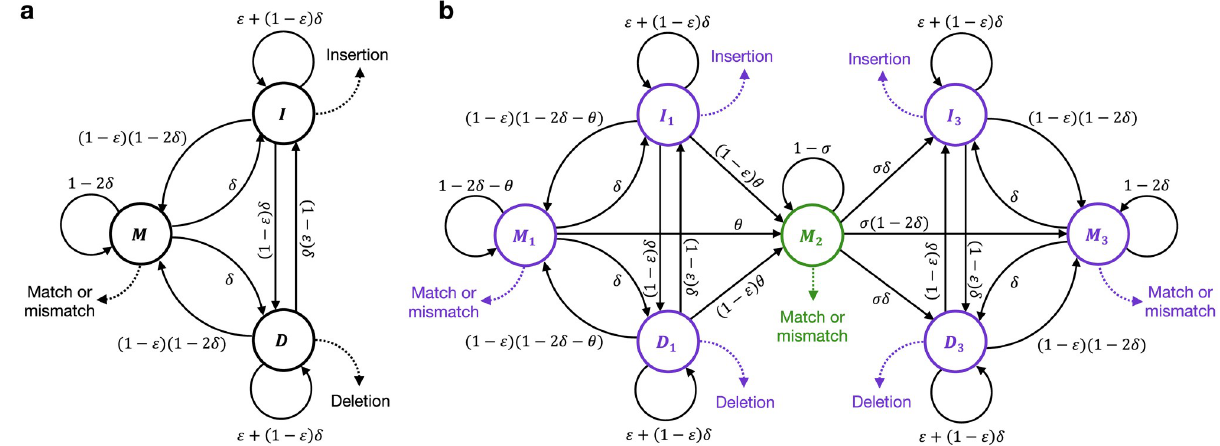
Fig 2. Models for unidirectional alignment and for (bidirectional) template switch alignment. (A) The unidirectional pairHMM. The model’s three states, M , I and D , represent respectively match/mismatch, insertion and deletion alignment columns. A match/mismatch ( M ) column is one where both sequences have a non-gap character; an insertion ( I ) column has a gap character ( − ) in the ancestral sequence; and a deletion column ( D ) has a gap character in the descendant sequence. The pairHMM graph illustrates the probabilities that one type of column follows another in a pairwise alignment, with δ and � representing gap opening and extension probabilities. For example, the directed edge from state M to state I , annotated with δ , denotes that the probability that an I column follows a M column is δ . Dashed arrows represent emissions (the observations of specific alignment columns given the corresponding state); for example, at an M column the two sequences can be either identical (“Match”) or contain different nucleotides (“Mismatch”), and one nucleotide from each sequence is emitted in this case. (B) The template switch alignment pairHMM. States M 1 , I 1 , D 1 emit fragment Ⓛ ! ① ; state M 2 emits fragment ② ! ③ ; and states M 3 , D 3 , and I 3 emit fragment ④ ! Ⓡ . Parameters θ and σ control the probabilities of template switch initialisation and extension, respectively. Purple states align forwards with respect to both sequences, whereas the green state aligns the two sequences in opposite directions. Emissions in state M 2 differ from M 1 and M 3 in that the emitted sequence respects the complementarity of the alternative template rather than a direct match between the two sequences at that position.